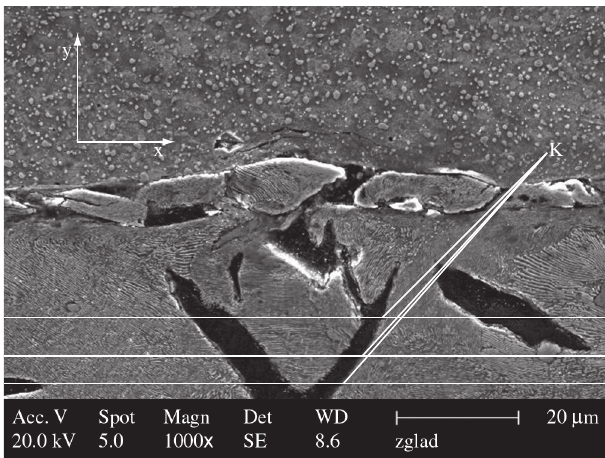
Figure 9. Positions of K points (borders between metallic structures and graphite flake) as a function of graphite shape.